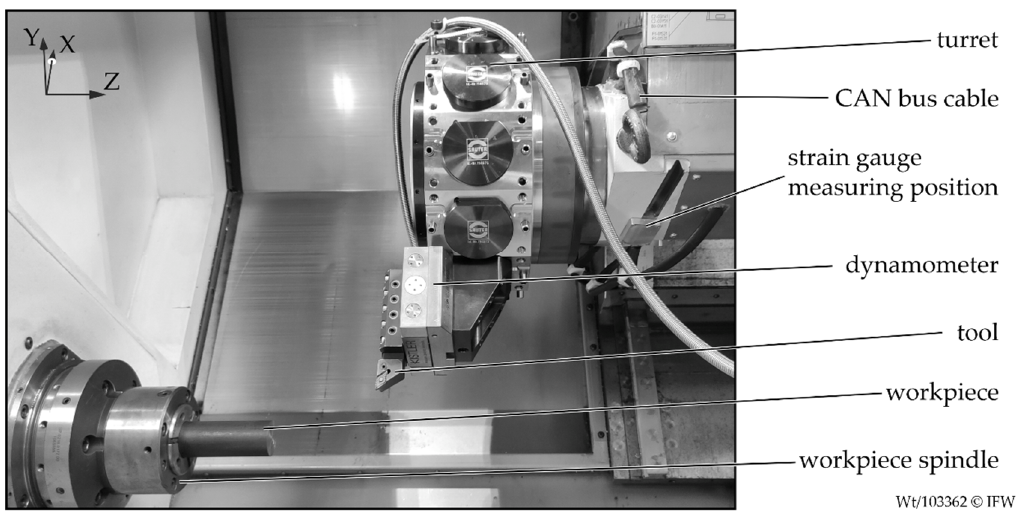
Figure 1. Presentation of the measurement setup.